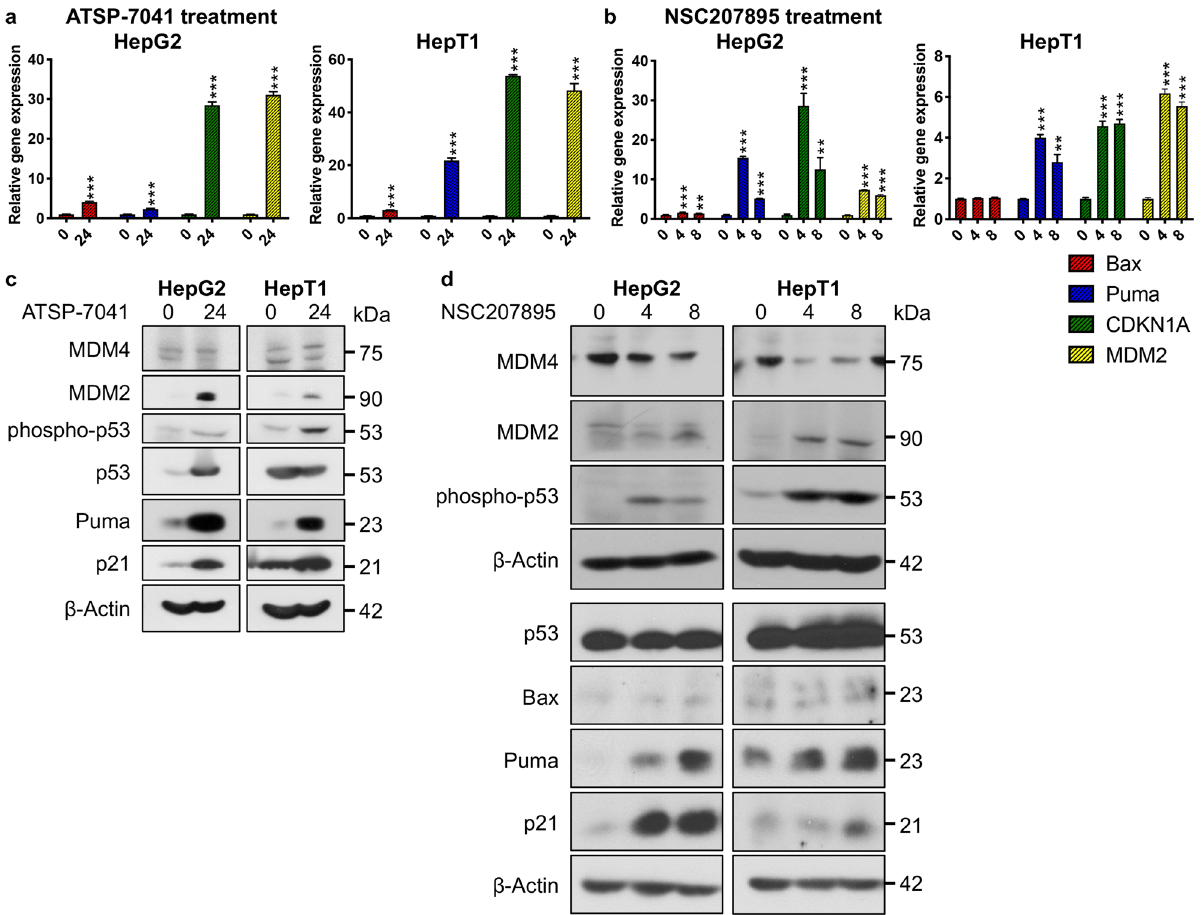
Figure 3. Acute MDM4 inhibition with ATSP-7041 and NSC207895 lead to upregulation of p53 activity and downstream signaling. ( a ) Bar graphs representing normalized mRNA expression of p53 targets Bax , Puma , CDKN1A , and MDM2 analyzed with qPCR experiments. RNA extracted from HepG2 and HepT1 cells treated with 10 μM ATSP-7041 for 24 h was compared to that from untreated cells (0 h). Error bars represent SD. Data shown are representative of at least three independent experiments performed with three replicate wells each time. Student’s t test (two tailed) * P < 0.05, ** P < 0.01, *** P < 0.001. ( b ) Bar graphs representing normalized mRNA expression of p53 targets Bax , Puma , CDKN1A , and MDM2 analyzed with qPCR experiments. RNA extracted from HepG2 and HepT1 cells after treatment with 10 μM NSC207895 for 4 or 8 h was compared to that from untreated cells (0 h). Error bars represent SD. Data shown are representative of at least three independent experiments performed with three replicate wells each time. Student’s t test (two tailed) * P < 0.05, ** P < 0.01, *** P < 0.001. ( c ) Protein lysis from cells treated with 10 μM ATSP-7041 for 24 h were compared to untreated cells (0 h). Immunoblotting was done with the indicated antibodies, including MDM4 (04–1555, Millipore). β-Actin immunoblotting was used as a loading control. Data shown are representative of at least three independent experiments. ( d ) Protein lysis from cells treated with 10 μM NSC207895 for 4 or 8 h were compared to untreated cells (0 h). Immunoblotting was done with the indicated antibodies, including MDM4 (04–1555, Millipore). β-Actin immunoblotting was used as a loading control. Data shown are representative of at least three independent experiments. Full length blots for data shown in c and d are presented in Supplementary Fig.